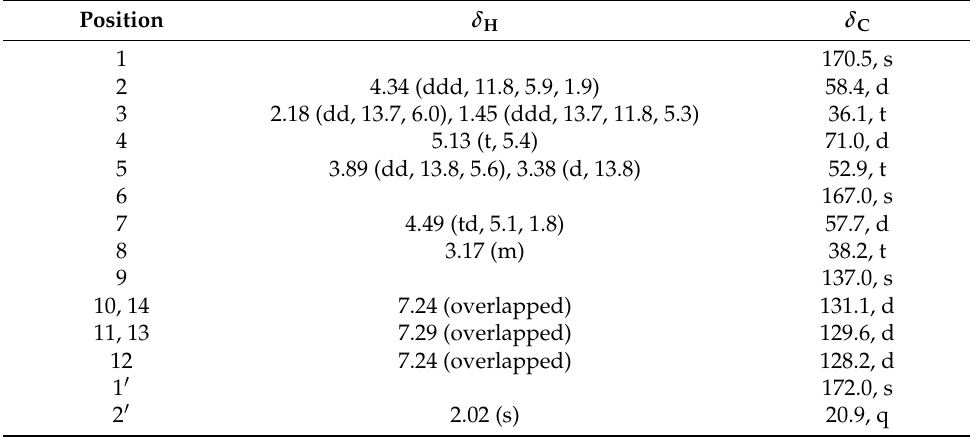
Table 1. 1 H and 13 C NMR data of 1 in methanol- d 4 , (TMS, δ in ppm, J in Hz).